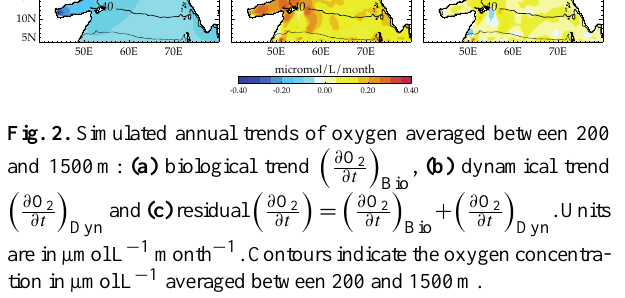
(cid:17) (cid:16) ∂ O 2 , (b) dynamical trend ∂t Bio (cid:16) ∂ O (cid:17) (cid:16) ∂ O (cid:17) (cid:16) ∂ O (cid:17) = + 2 2 2 . Units ∂t ∂t ∂t Bio Dyn